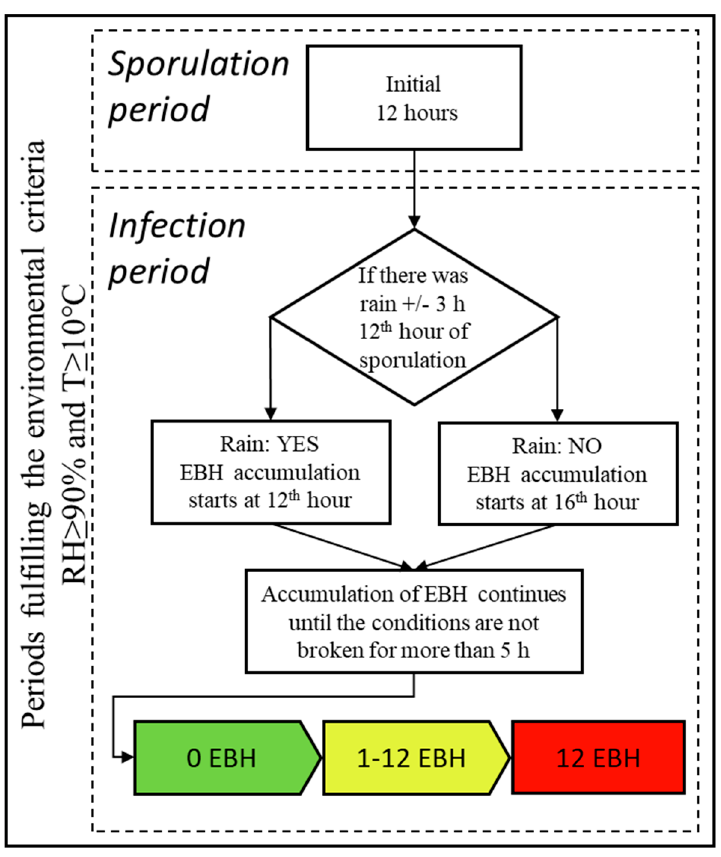
Figure 2. Simplified presentation of the Irish Rules algorithm. The operational warning threshold scale is presented as the “traffic light” scheme, ranging from green (no warning), to yellow when the warning considered and red when the warnings are issued without delay.